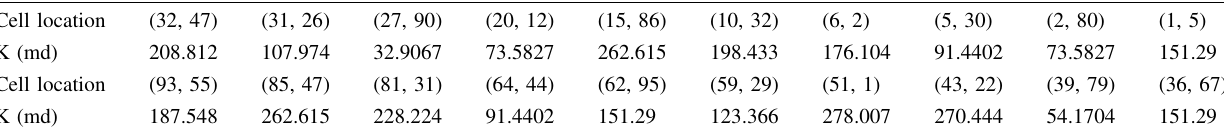
Table 1 Known permeability data in the reservoir model Cell location